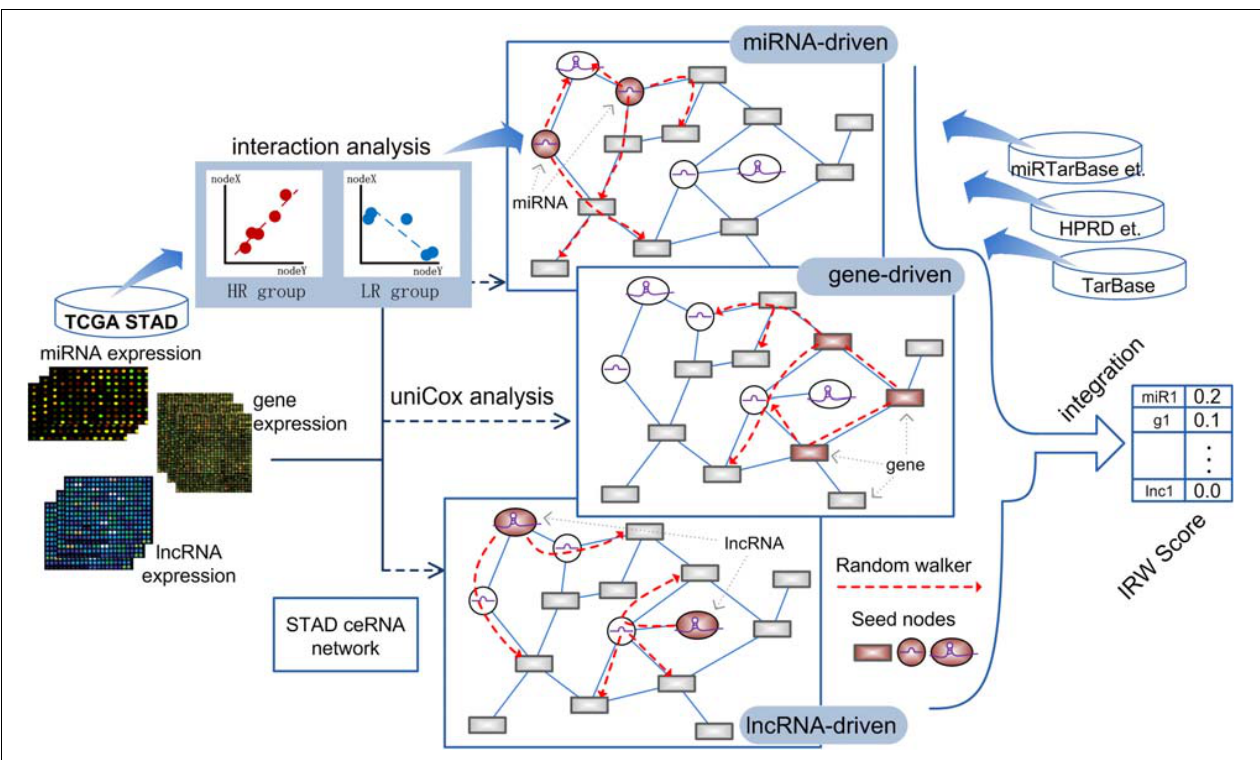
FIGURE 1 | The workflow of calculating IRW